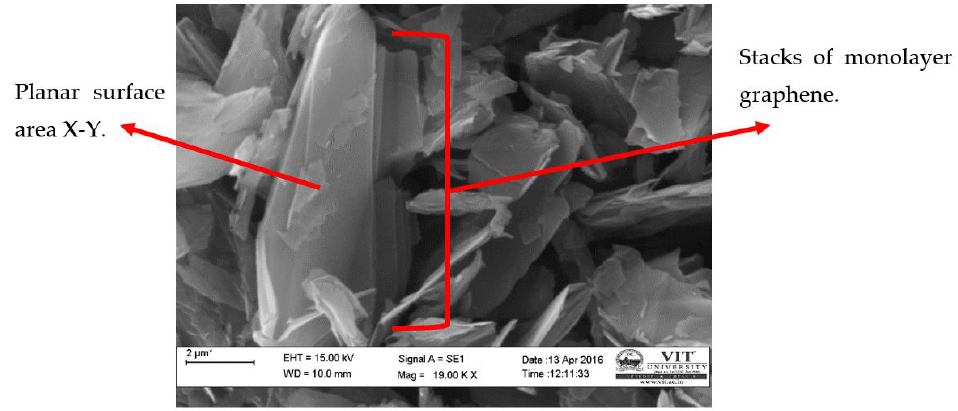
Figure 2. FE-SEM image of as received graphene Nano